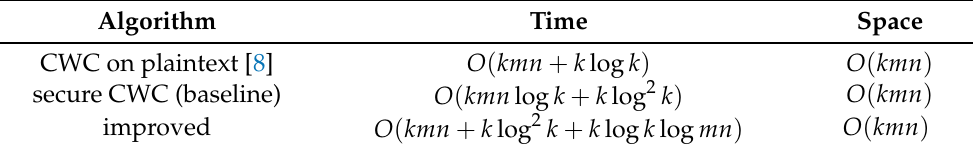
Table 2. Time and space complexities of the baseline and improved algorithms for secure CWC, where k is the number of features and m , n are the numbers of positive and negative data, respectively. We as- sume that the time of the respective operation (e.g., encryption/addition/multiplication/comparison) in FHE is O ( 1 )